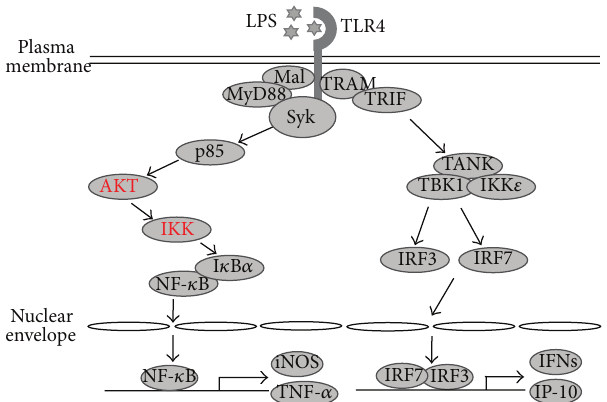
Figure 2: Syk-regulated signaling pathways in macrophage-mediated inflammatory